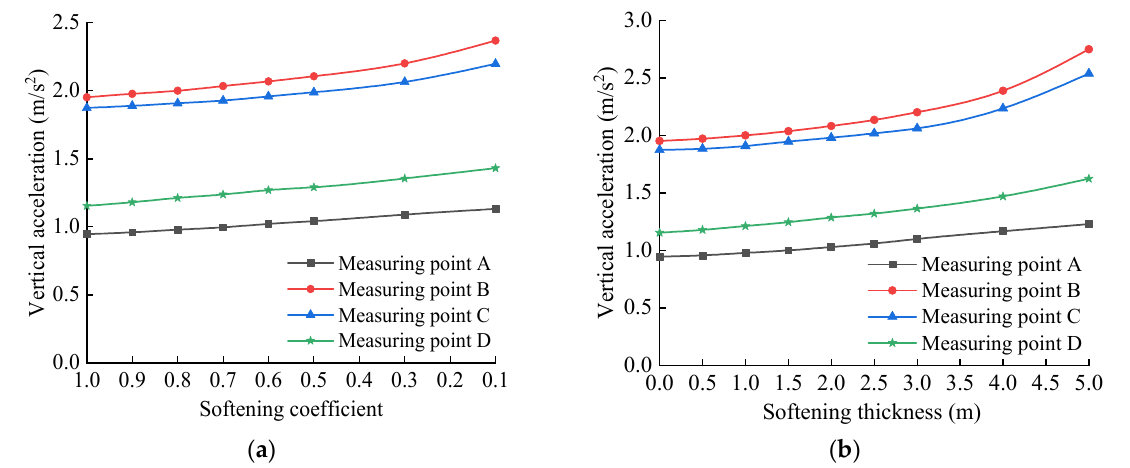
Figure 12. Vertical accelerations peak change curve of base measuring point: ( a ) Relationship between vertical displacement and softening coefficient; ( b ) Relationship between vertical displacement and softening thickness.